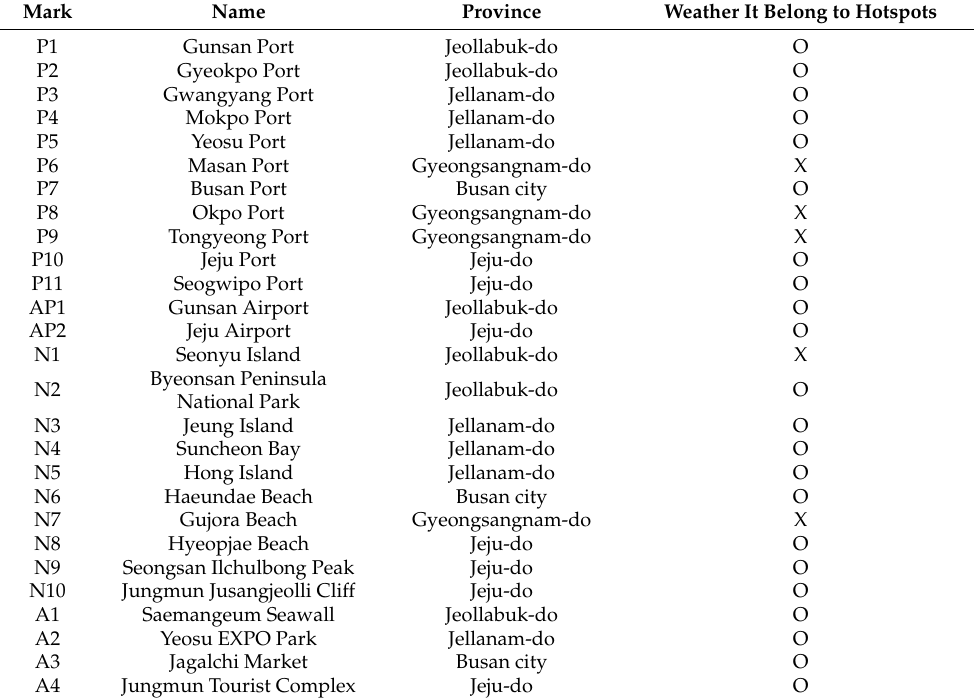
Table A3. The list of main tourist attraction in Figures 4 and